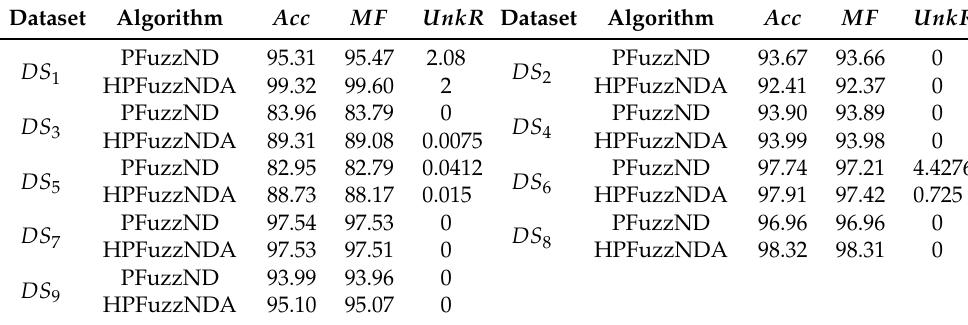
Table 5. Results obtained by PFuzzND and HPFuzzNDA on benchmark problems.